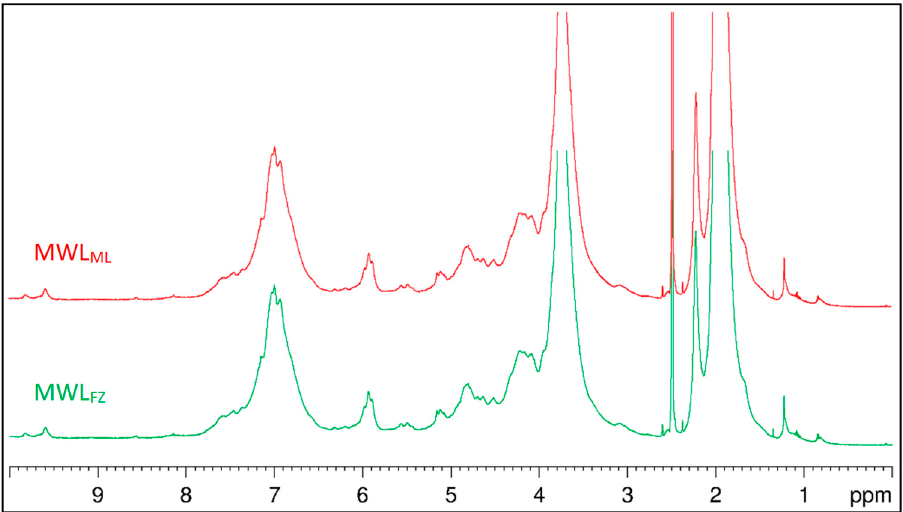
Figure 2. The 1 H NMR spectra of MWL ML and MWL FZ .